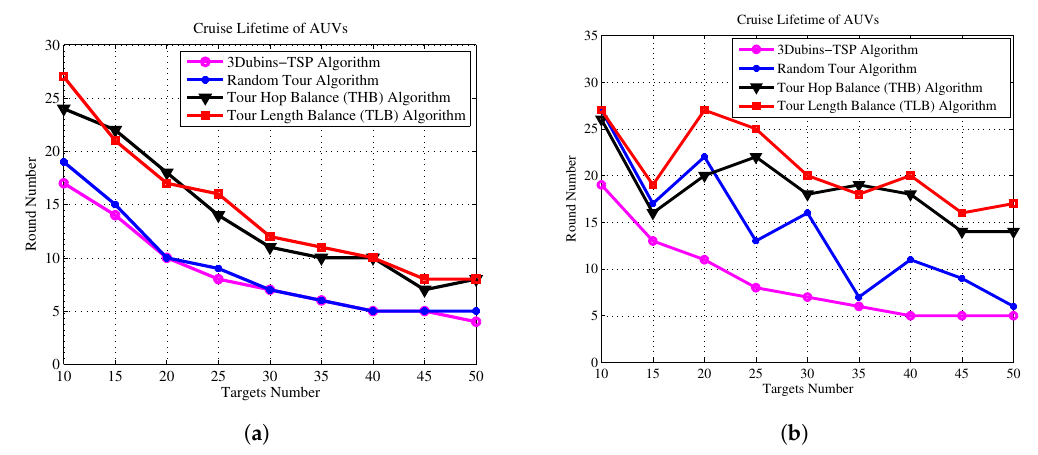
Figure 14. Task life cycle comparisons. ( a ) 2 AUVs; ( b ) 4